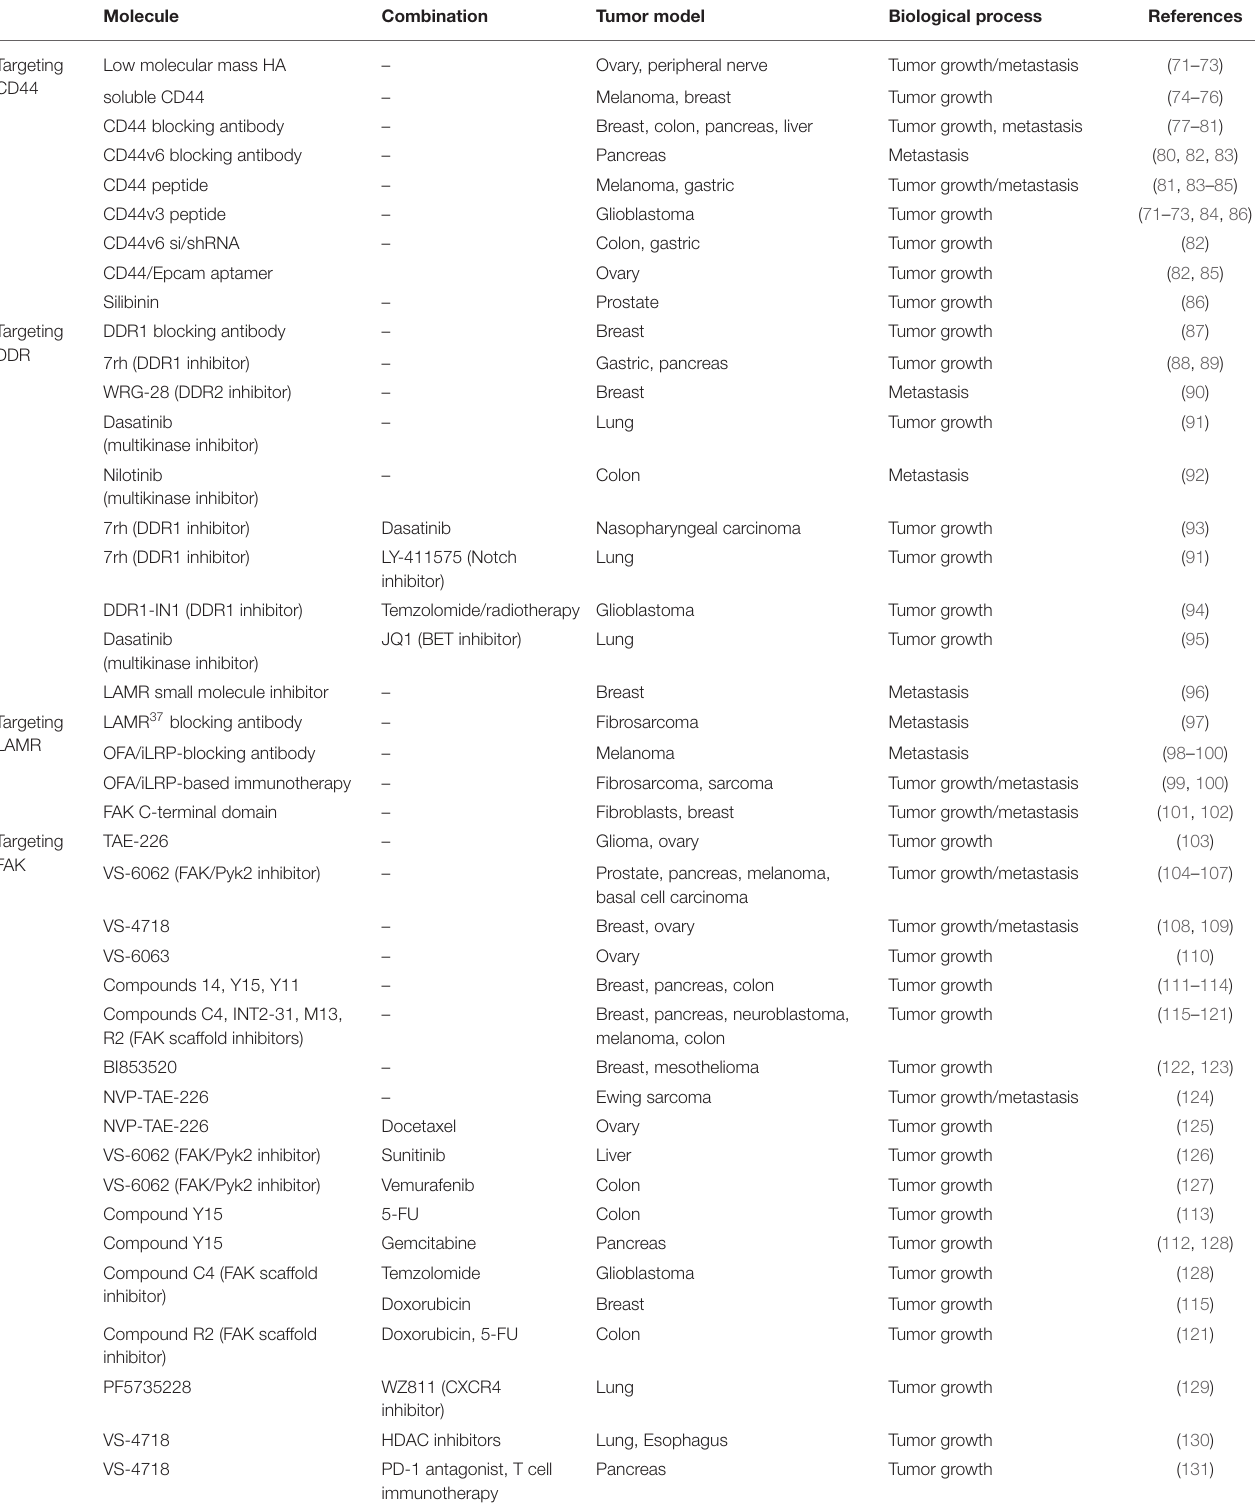
TABLE 1 | In vivo preclinical studies for solid tumors.